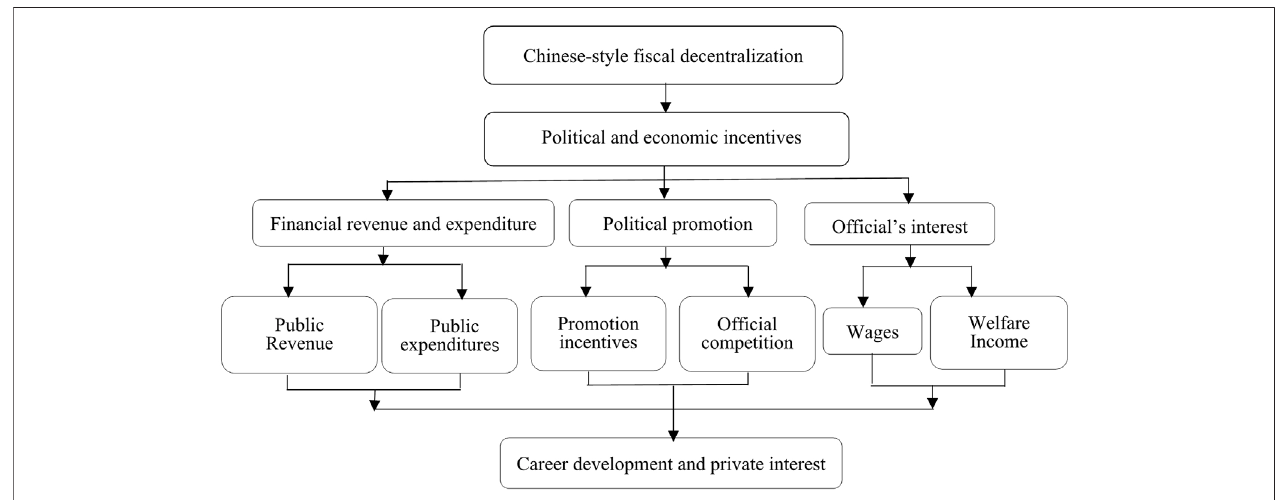
FIGURE 1 | Dual incentives of local